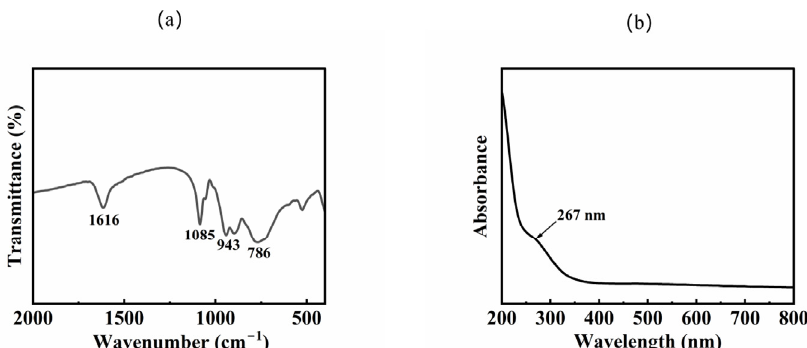
Figure 1. IR spectrum of Cu 4 P 4 W 30 ( a ) and UV-vis spectrum of 10 − 5 M Cu 4 P 4 W 30 ( b